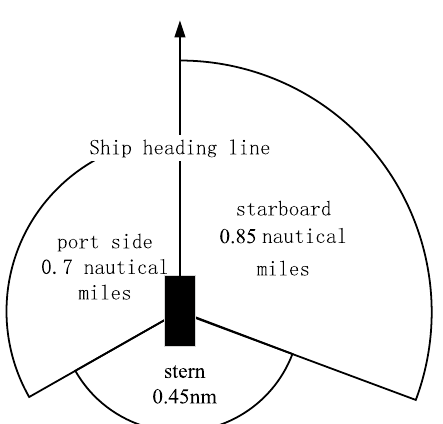
Fig. 7 GOODWIN ship domain model.The schematic diagram of the GOODWIN ship domain model, which is an improved version of FUJII ship domain